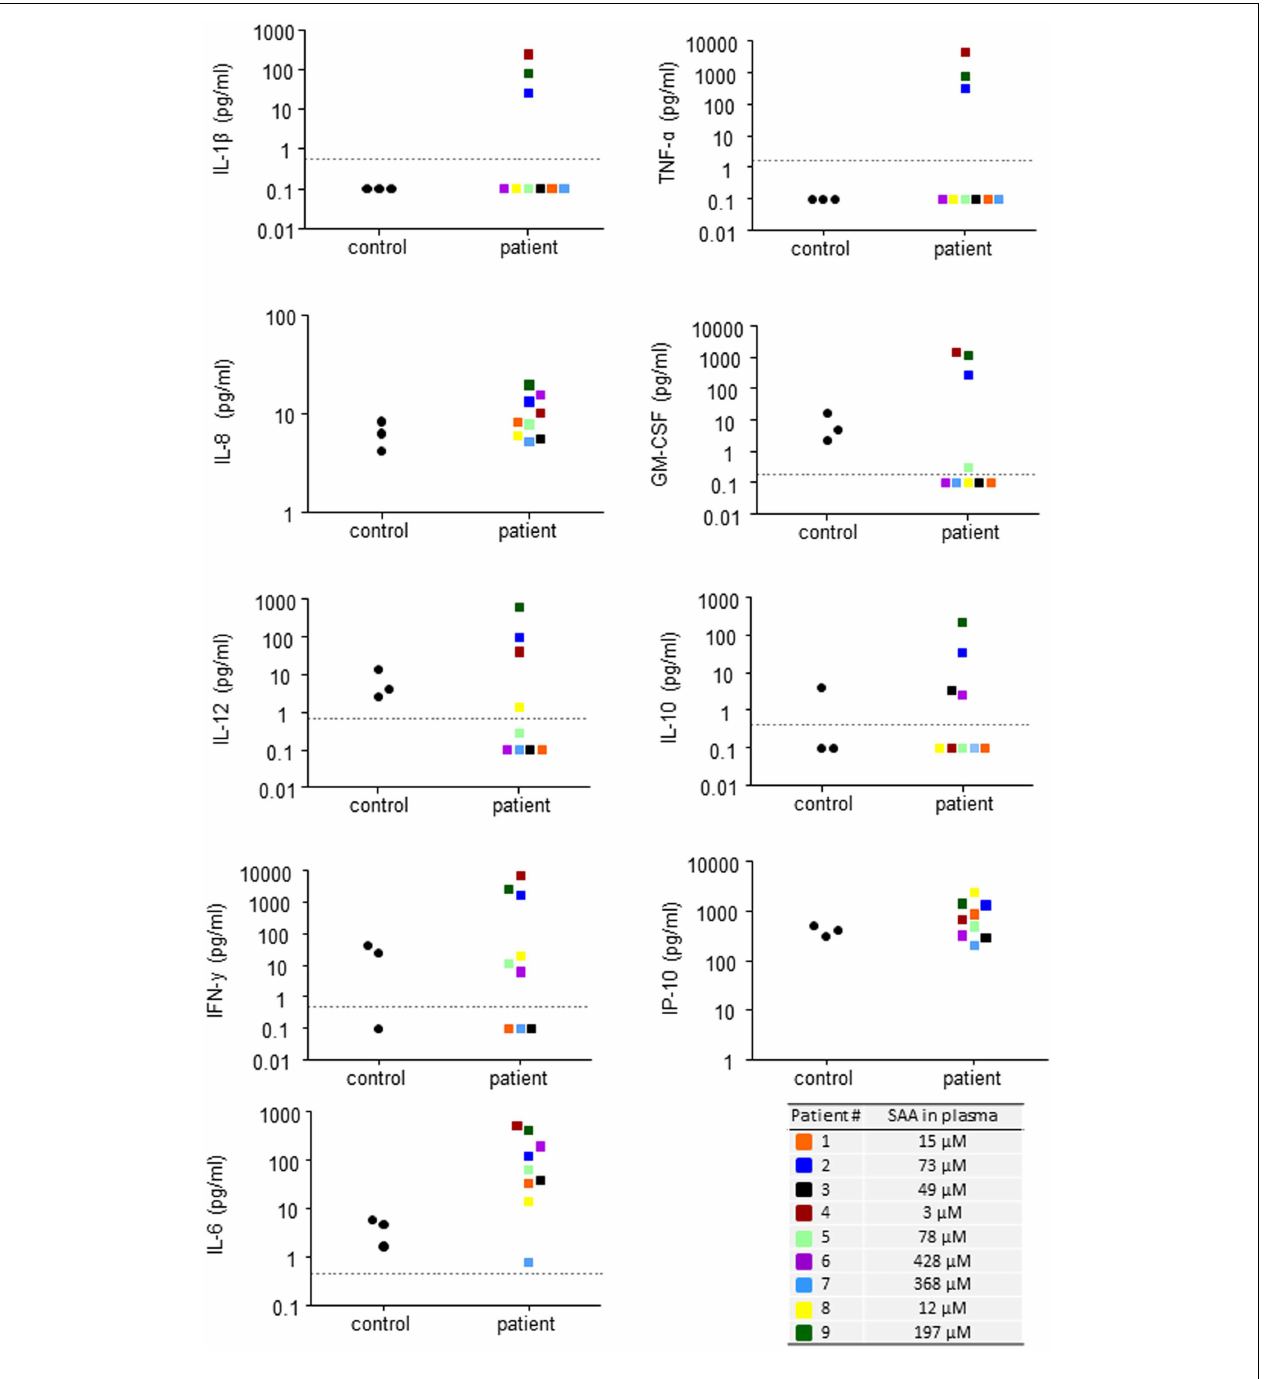
FIGURE 3 | High SAA levels in blood do not correspond to increased levels of inflammatory cytokines . Plasma levels of inflammatory cytokines in the individual patients included in the study. Dotted lines represent the